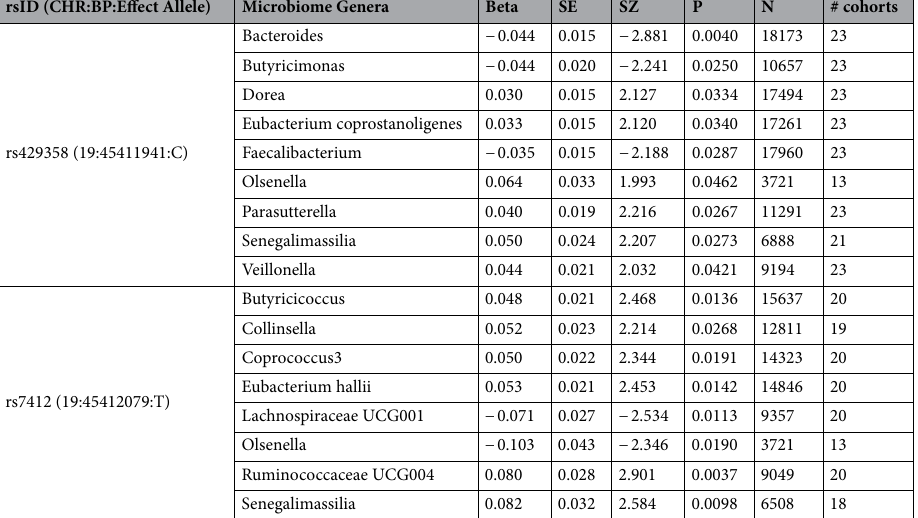
Table 5. List of gut microbiome genera that were nominally associated with APOE SNPs rs429358 and rs7412. SNP data were extracted from GWAS summary statistics of human gut microbiome abundance conducted from 24 multi-ethnic cohorts in the MiBioGen consortium (www. mibio gen. org) 24 . rsID (CHR:BP:Effect Allele): the rs number of single nucleotide polymorphisms, chromosome number (CHR), base pair (BP), with the effect allele (genome assembly GRCh37/hg19). Microbiome: the genus level with significant abundance associated with APOE two SNPs. Beta: Beta coefficient. SE: Standard Error. SZ: Weighted sum of z-scores. P: p -value ( p < 0.05 was considered as nominal association between the microbiome genera and APOE ). N: sample count. # Cohorts: Number of cohorts